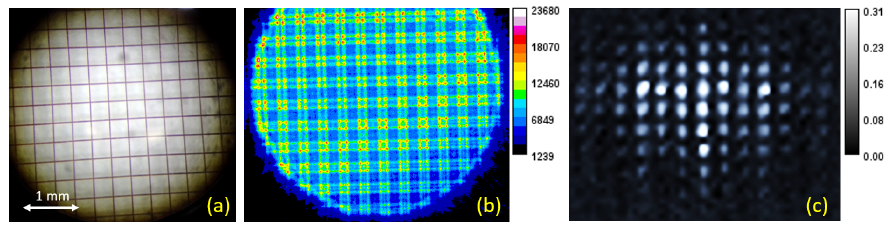
Figure 6. XUV radiation overall coherence measurements. ( a ) The 70 lines per inch copper mesh. ( b ) The diffraction image obtained after illuminating the copper mesh with the full XUV spectrum. ( c ) Reconstructed image of the copper mesh. Axes in ( b , c ) are in